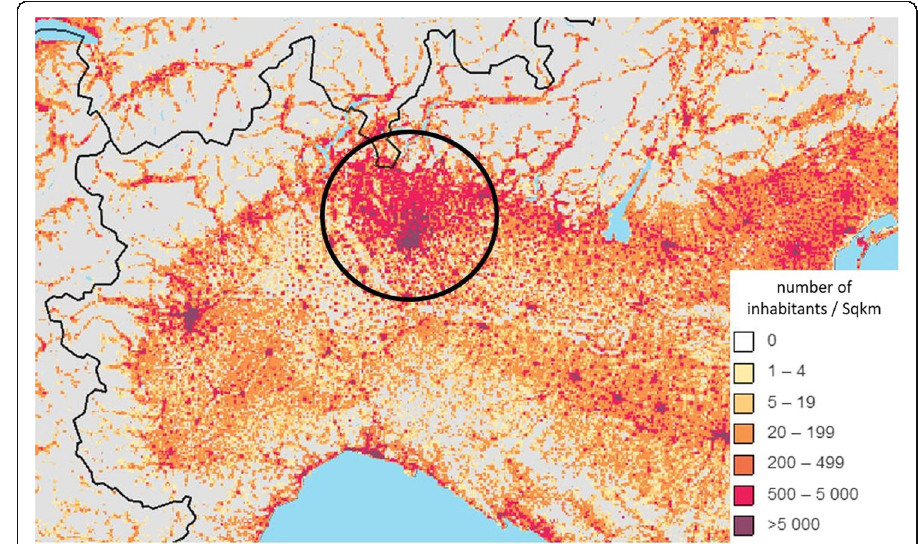
Fig. 1 Population density in the reference area. Source: JRC, Eurostat, GEOSTAT Population Grid